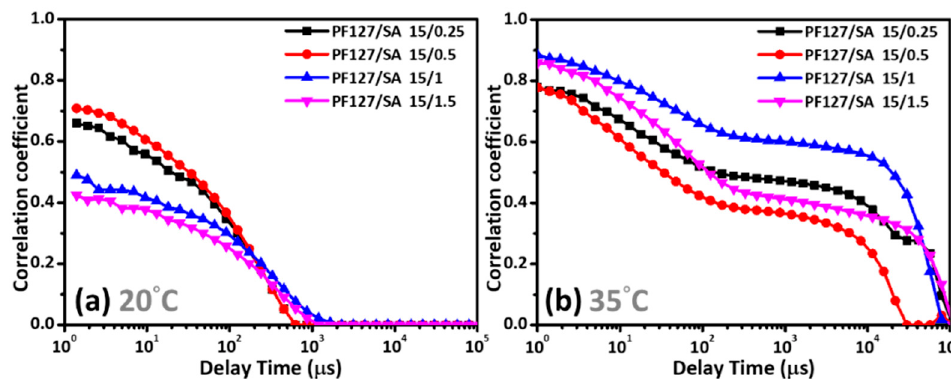
Figure 2. SA concentration e ff ects on the correlation coe ffi cients of thermosensitive PF127 / SA hydrogels at ( a ) 20 ◦ C and ( b ) 35 ◦ C. The correlation coe ffi cient as a function of time was obtained by dynamic light scattering measurements for various temperatures.